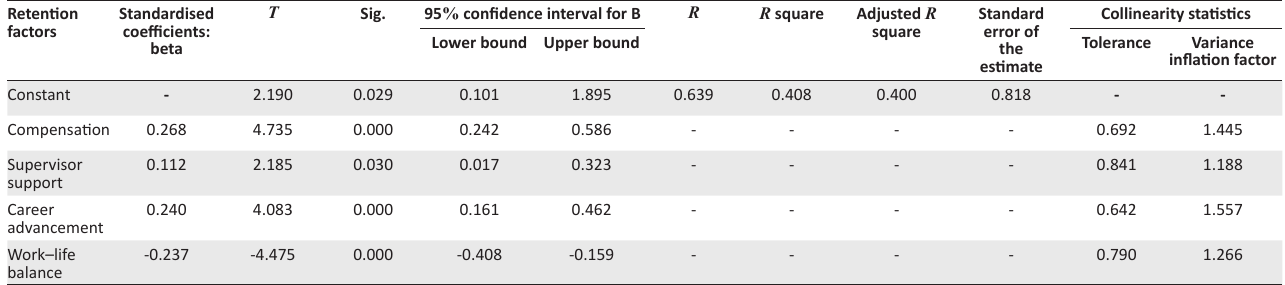
TABLE 3: Multiple regression analysis.